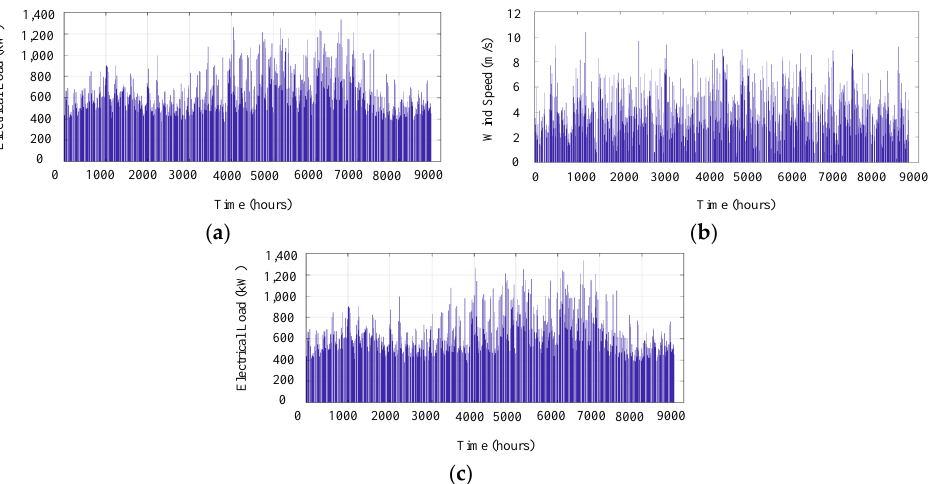
Figure 2. Hourly profiles: ( a ) electrical load; ( b ) wind speed; ( c ) solar radiation.